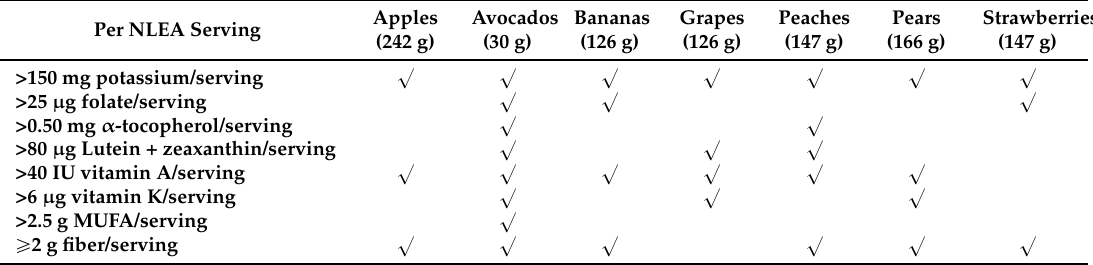
Table 1. Meeting the developmental needs of infants and toddlers. Comparison of a serving (30 g) of avocado versus a Nutrition Labeling and Education Act (NLEA) serving (Range: 126–242 g) of the most popular complementary and transitional